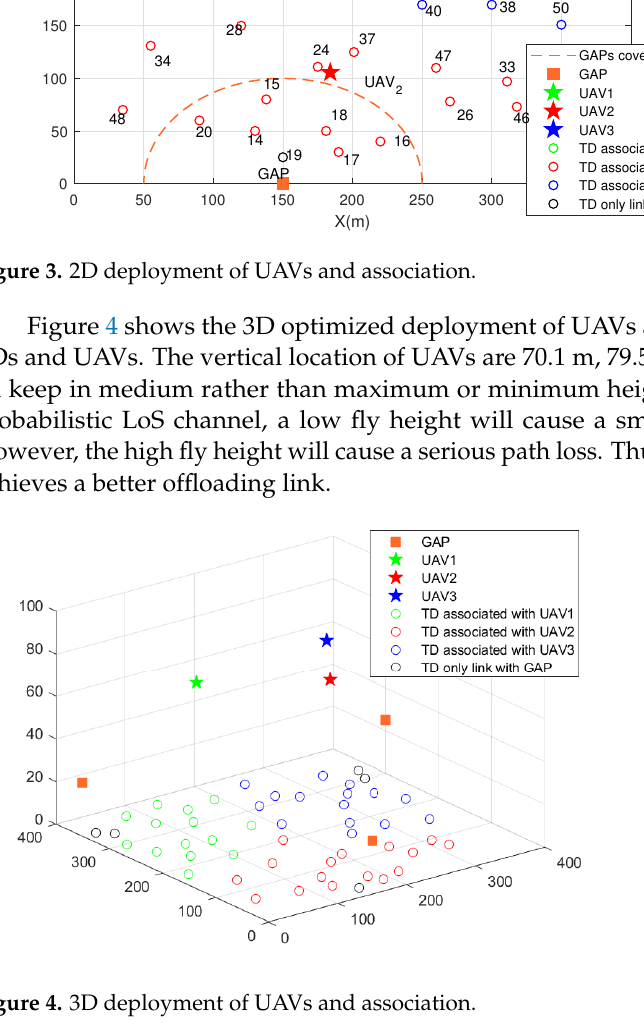
Figure 4. 3D deployment of UAVs and